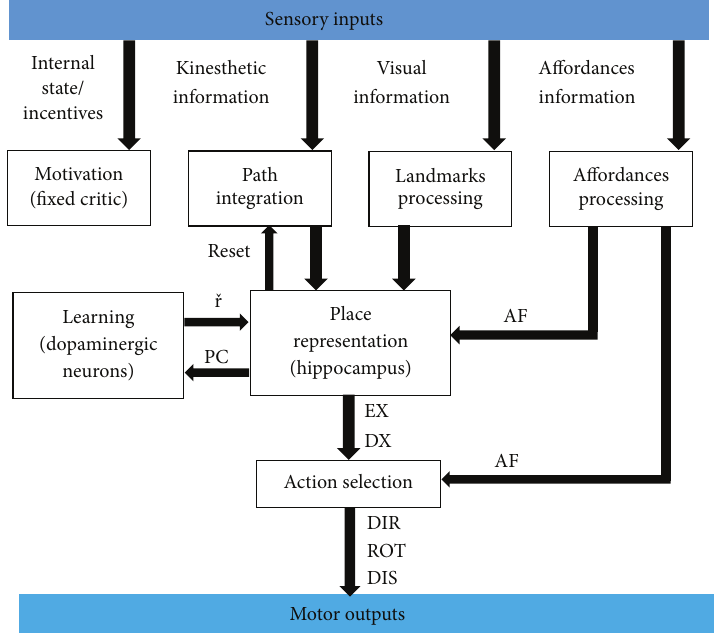
Figure 6: Computational spatial cognitive model of the Barrera and Weitzenfeld neurophysiologically based mobile robot navigation system. Some submodules and neurophysiological framework are not shown and can be found in [22]. ˇr = effective reinforcement; PC = place information pattern; EX = expectations of maximu reward on their corresponding directions (DX); DIR = next rat direction; ROT = rat rotation; and DIS = next rat moving displacement.